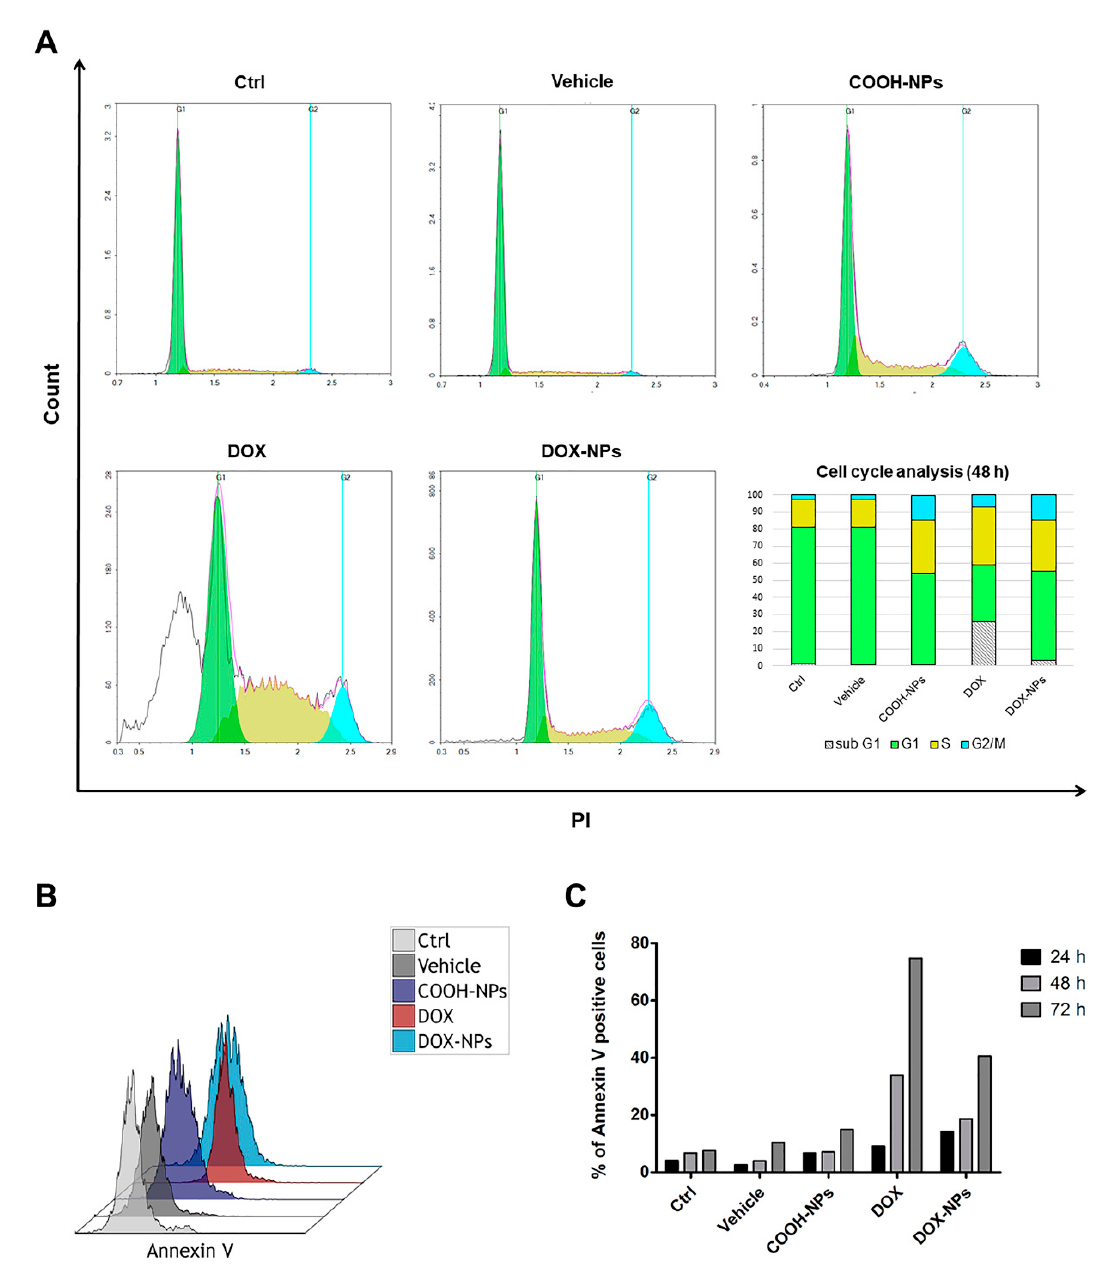
Figure 8. Investigation of cell death features on MCF-7 cells after treatment. MCF-7 were incubated with medium (Ctrl neg), DMSO (vehicle), COOH-NPs (diluted 1:50), free DOX (1 µg/mL) and DOX- NPs (1 µg/mL of DOX) for 24, 48 and 72 h at 37 °C. ( A ) Representative DNA histograms (obtained by PI staining) of MCF-7 cell cycle analysis after 48 h exposure. Bar graph indicates the percentages of cell distribution in different phases of cell cycle (sub-G1, G1, S and G2/M) for control and treated cells after 48 h. ( B ) Exemplifying flow cytometry histogram overlay for MCF-7 treated for 48 h and stained with Annexin V-FITC to investigate cell surface expression of phosphatidylserine, as marker of apoptosis. ( C ) The histogram presents the percentage of Annexin V positive cells detected through flow cytometry during time ( n = 2).